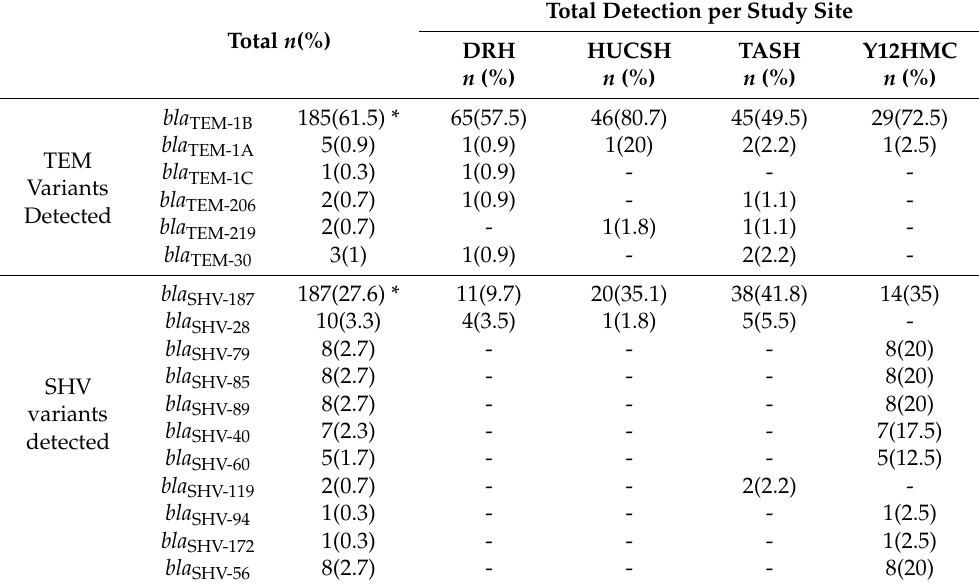
Table 5. Frequencyanddistributionofother bla TEM and bla SHV